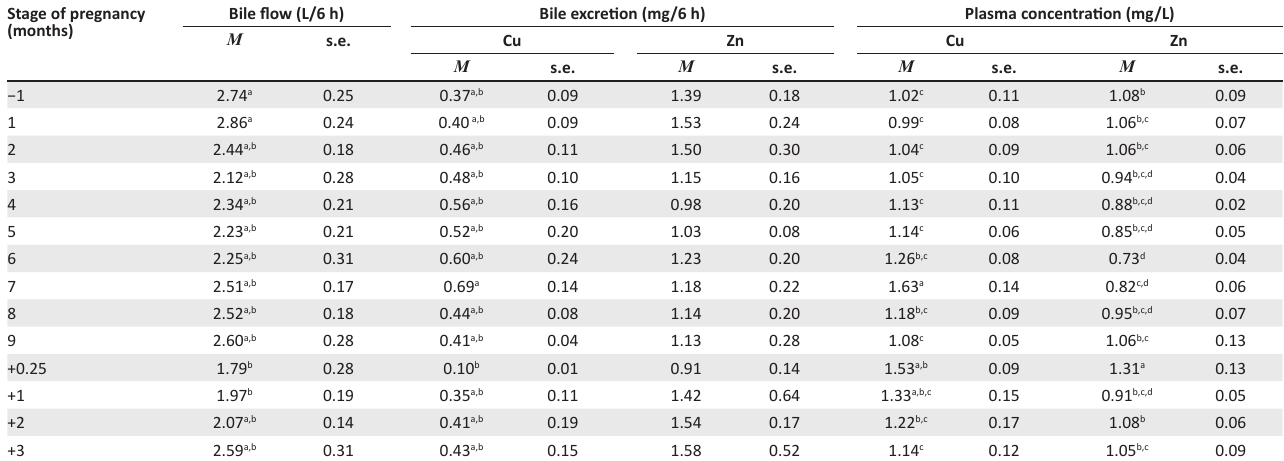
TABLE 1: Pooled bile flow, biliary copper and zinc excretion, and plasma copper and zinc concentrations in cattle prior to, during and after parturition. Stage of pregnancy Bile flow (L/6 (months)